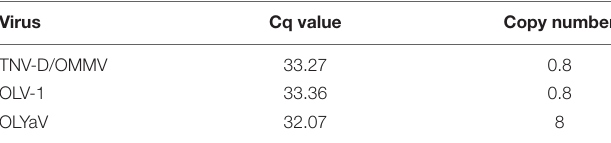
TABLE 3 | Detection limits of each of the three qPCR assays based on determination of copy numbers.